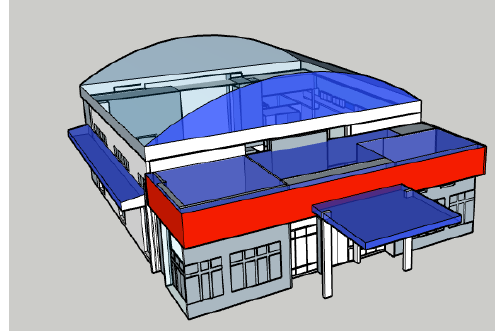
Figure 3. The representation of occupied space from exterior